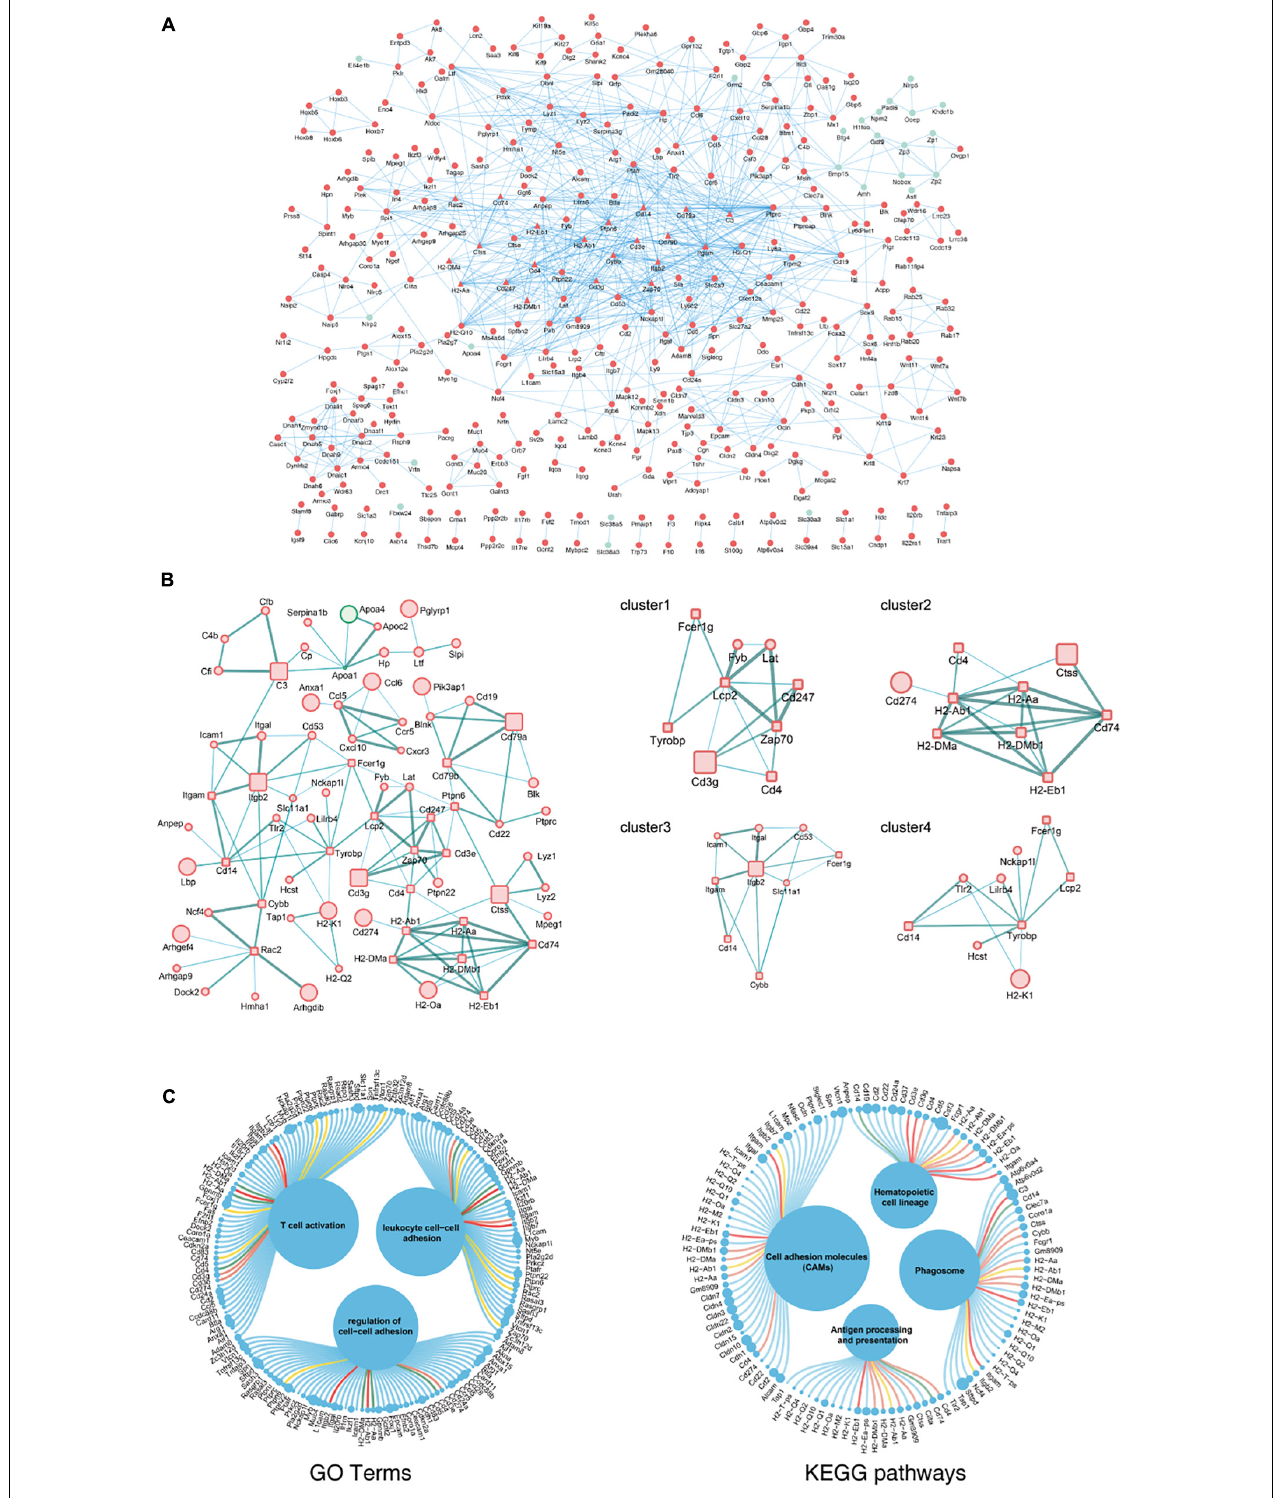
FIGURE 3 | PPI network complex of DEGs in ovarian aging. Red nodes represent upregulated genes; green nodes represent downregulated genes. Round rectangle nodes represent hub genes (A) . Four of the highly connected clusters were identified by centrality calculating algorithms and visualized by the Centiscape plugin of Cytoscape. Interactions are color coded according to combined scores with darker edges corresponding to higher scores (B) . Plot of hub genes displayed in top GO terms and KEGG pathways. Size of circles represents the relative mRNA expression of the genes (C) .